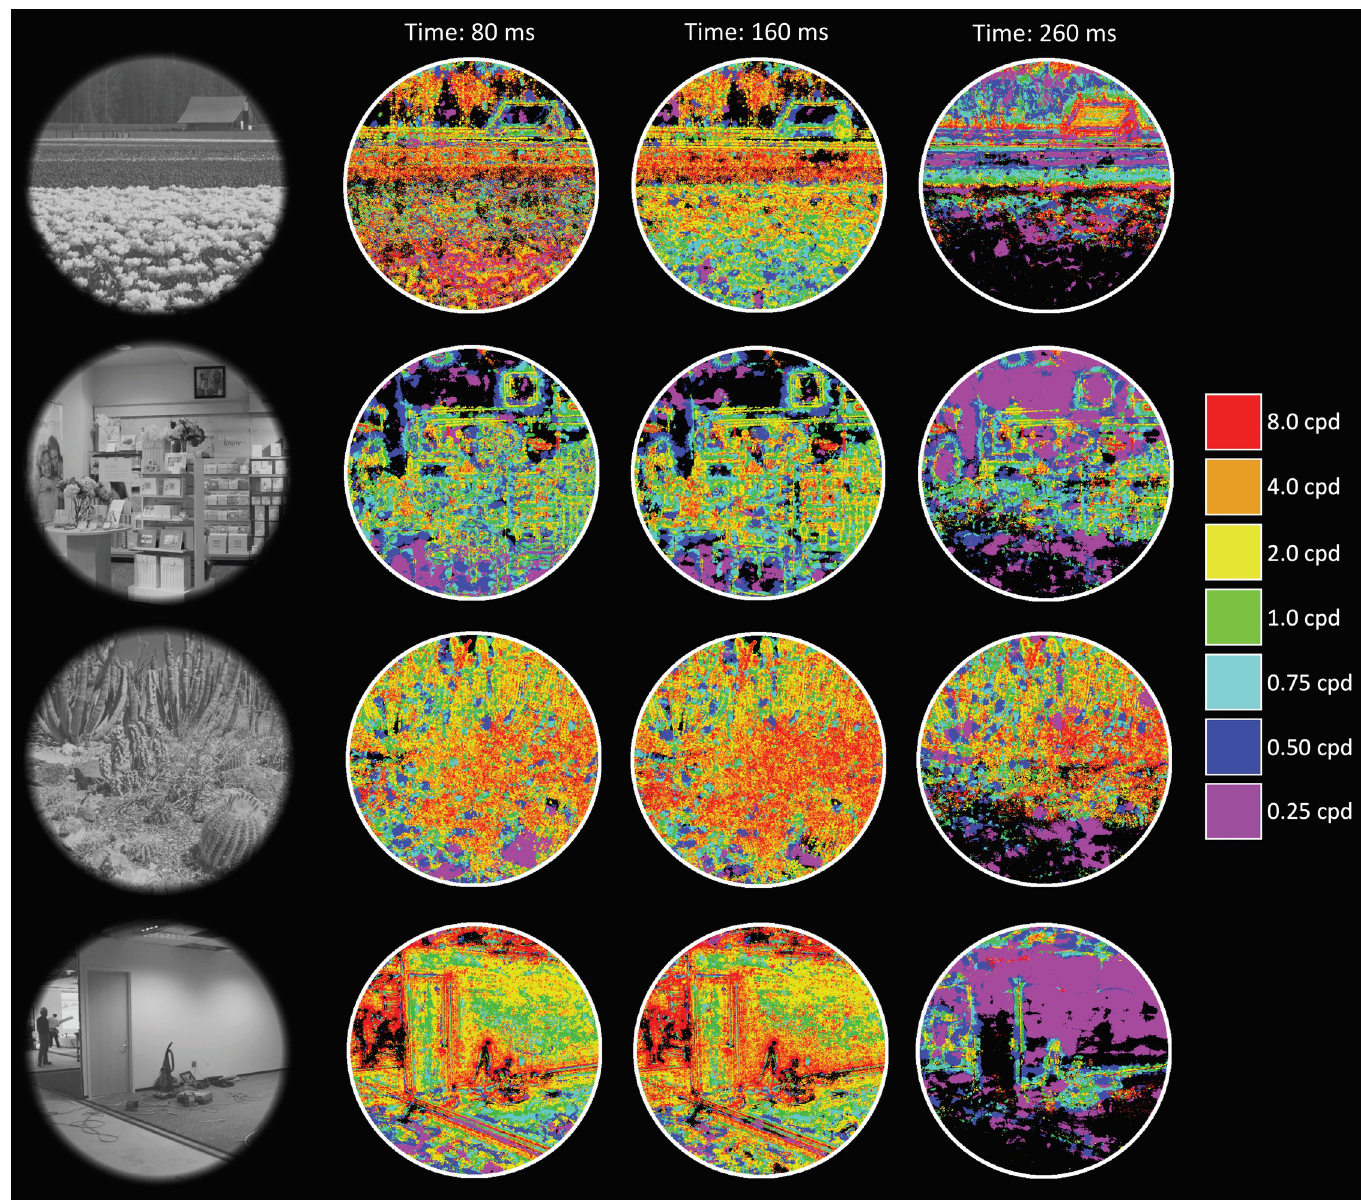
Fig 8. Additional stimulus examples and their DETI maps at different time points from electrode